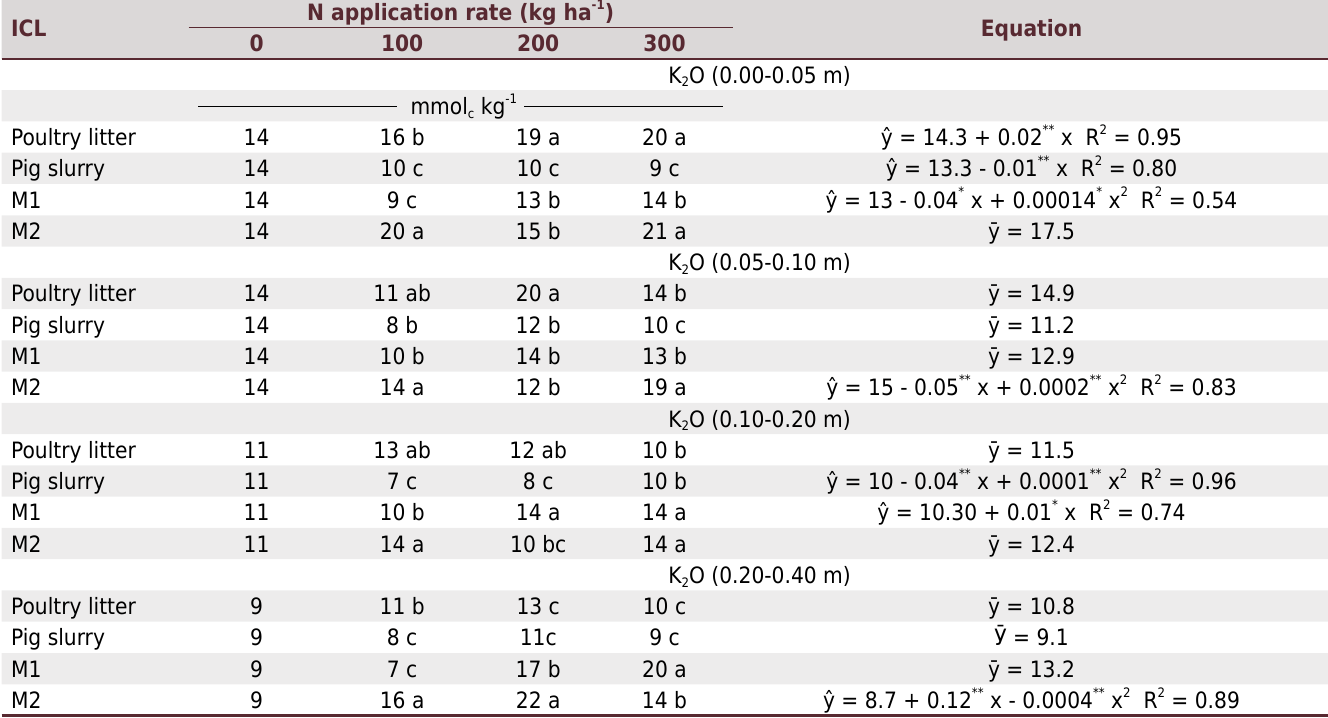
Table 6. Potassium content in soil according to organic and mineral fertilizers application in integrated crop-livestock systems in 2013 N application rate (kg ha -1 ICL